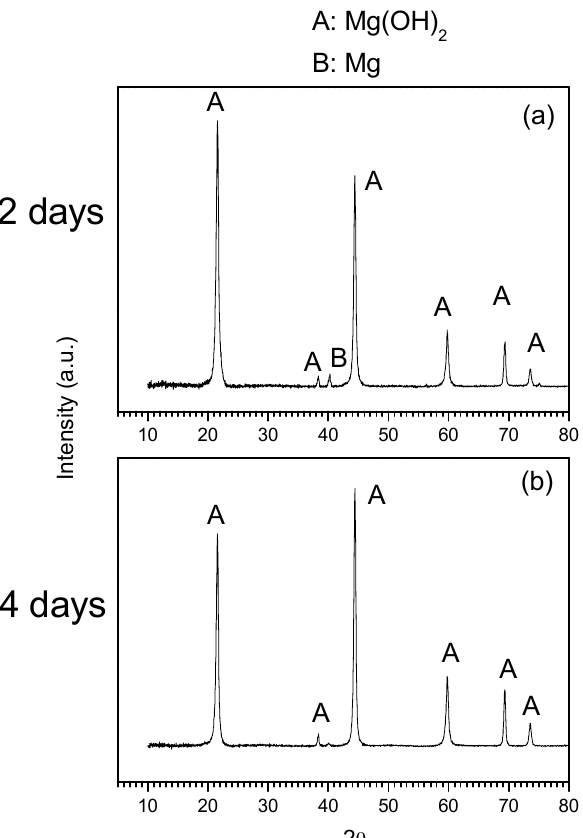
Figure 3. Low-angle XRD spectra of AZ31B surface after immersion in Ringer ′ s solution (37 °C) for 2 and 4 days.